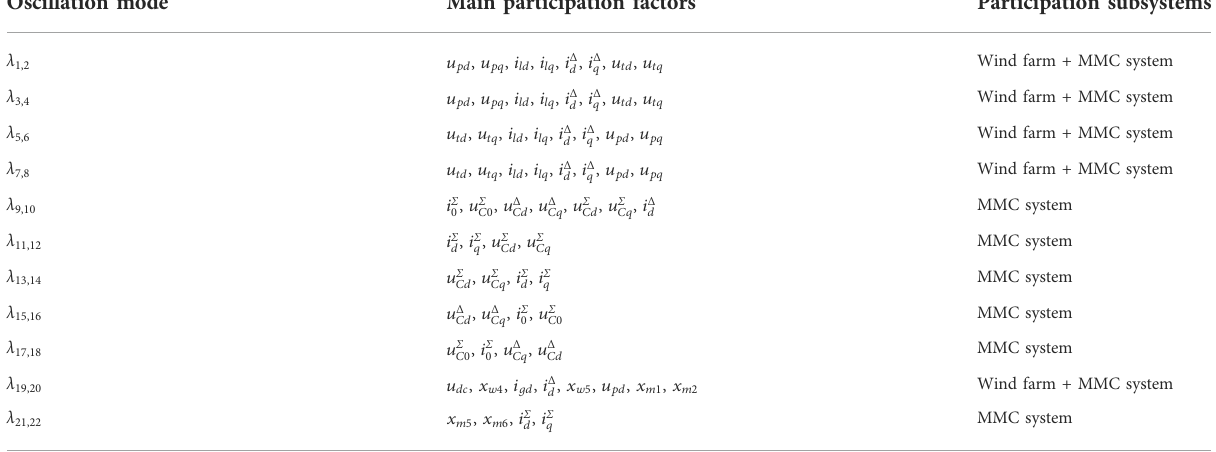
TABLE 6 The main participation factors and subsystems of each oscillation